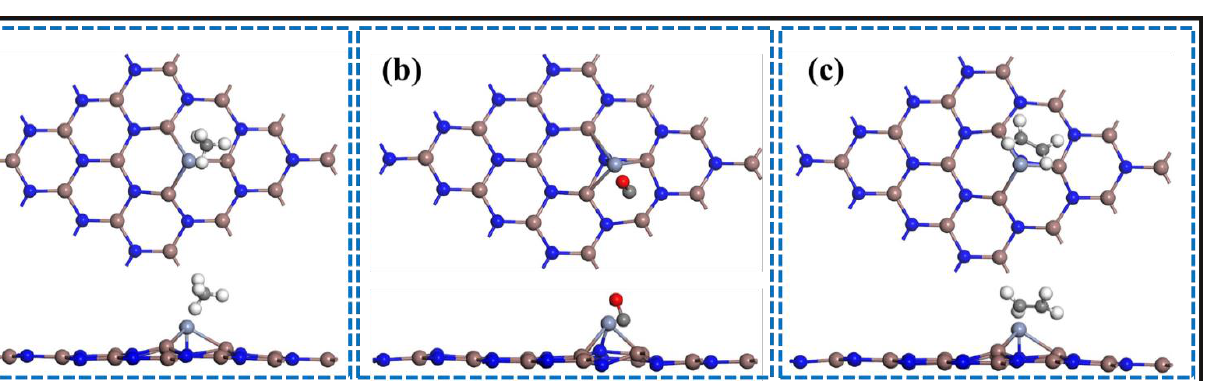
Figure 4. The adsorption energy and adsorption distance of CH 4 , CO, and C 2 H 4 on the Cr-InN mon- olayer. 3.3. Electron Density Analysis for Adsorption System Electron density reveals the probability that electrons are distributed in a particular location surrounding an atom or molecule. By calculating the deformation charge density (DCD), bond formation can intuitively observed and charge transfer can be qualitatively analyzed in an adsorption system [30]. The charge transfer values of CH 4 , CO, and C 2 H 4 are shown in Table 1, and the deformation charge density is shown in Figure 5. Table 1. The charge-transfer capacity of CH 4 , CO, and C 2 H 4 on the Cr – InN monolayer. Adsorption System